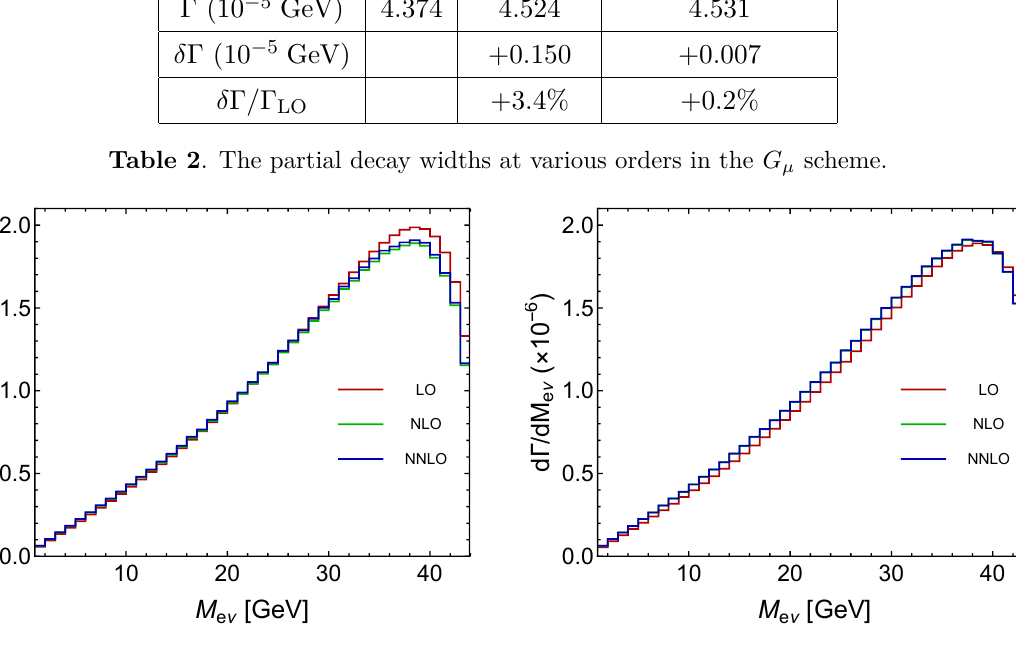
Figure 2 . The M eν distribution in the α ( m Z ) scheme (left) and in the G µ scheme